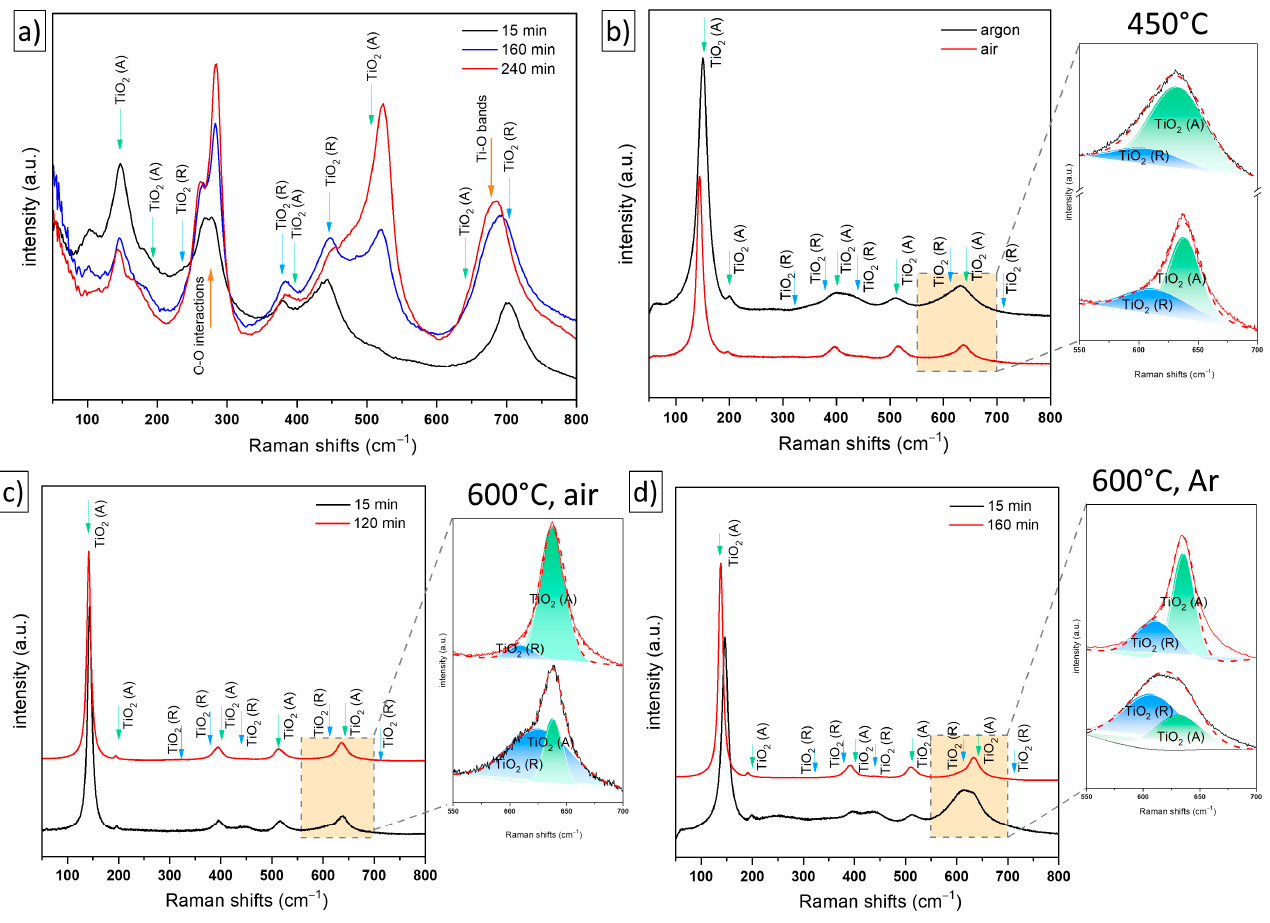
Figure 3. The Raman spectra of the ( a ) as-obtained nanostructured layers, after annealing at ( b ) 450°C, and at 600° ( c ) in the air, and ( d ) argon atmosphere.